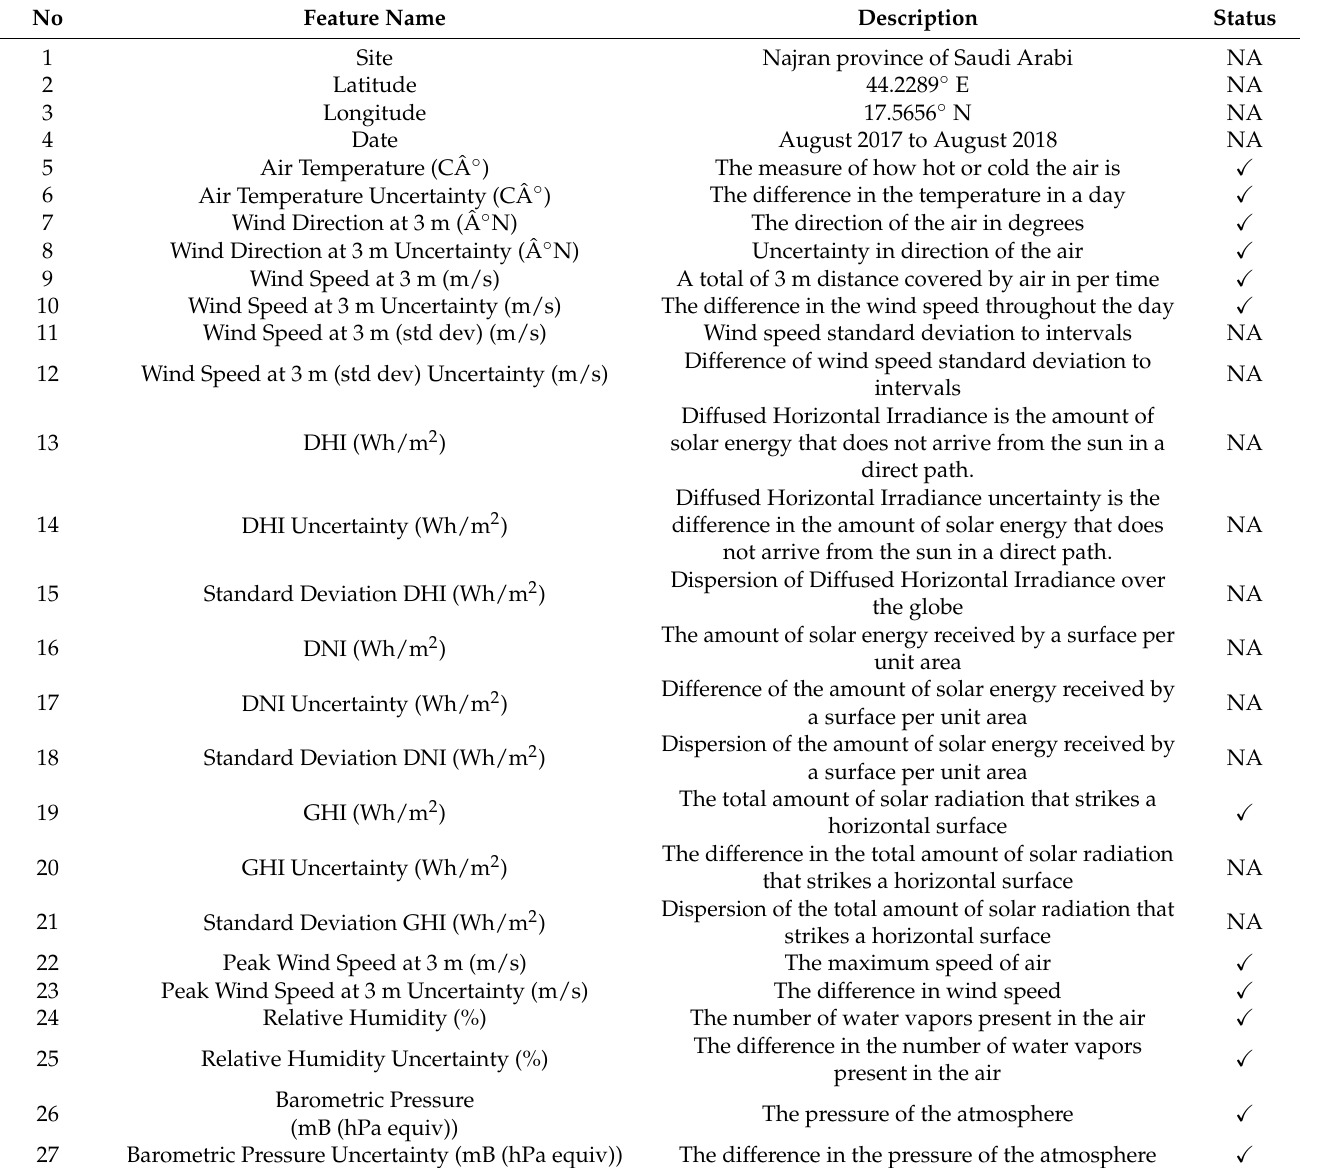
Table 1. Dataset